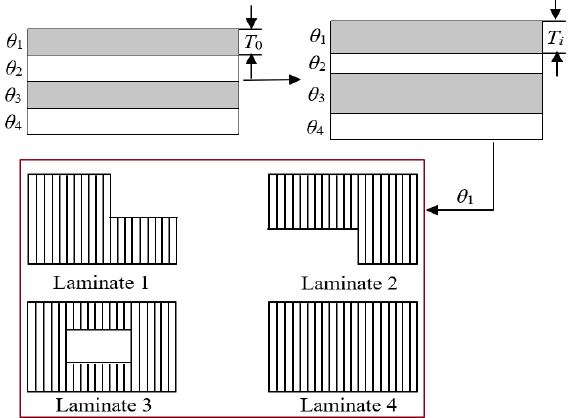
Figure 15. Schematic diagram of super layer analysis.